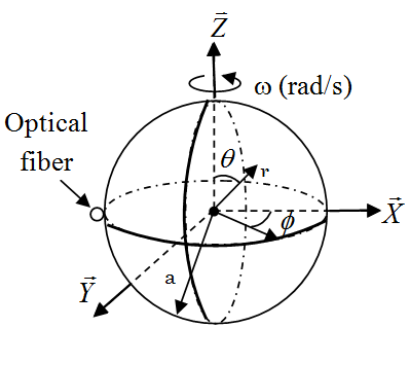
Figure 3. Geometry of a rotating